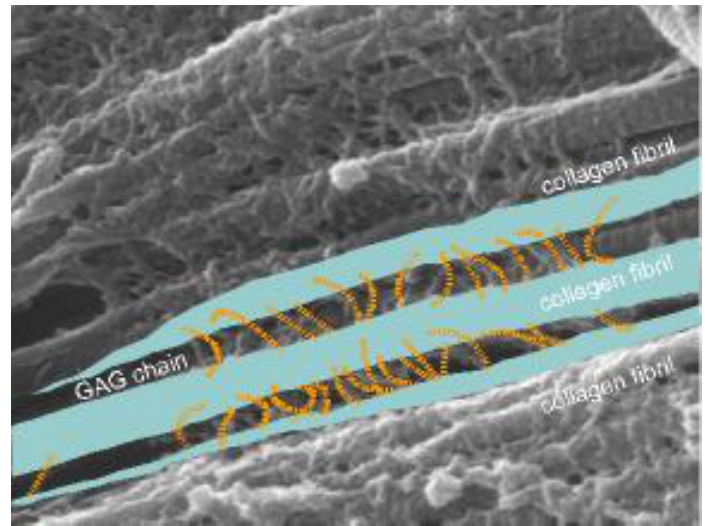
FIGURE 1. Scanning electron micrograph of rat tail tendon. The linkage between adjacent fibrils, mediated by GAGs’ chains, is shown. The thick interweaving of collagen fibrils (green) and GAGs’ chains (orange), responsible for distributing the mechanical loads across the whole tissue, is also delineated. The horizontal field of view spans 2 μ m[10]